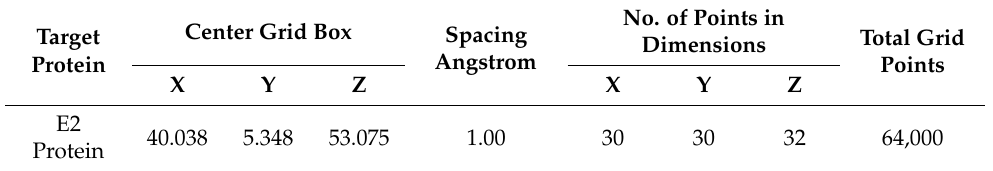
Table 5. Grid data for binding site during docking